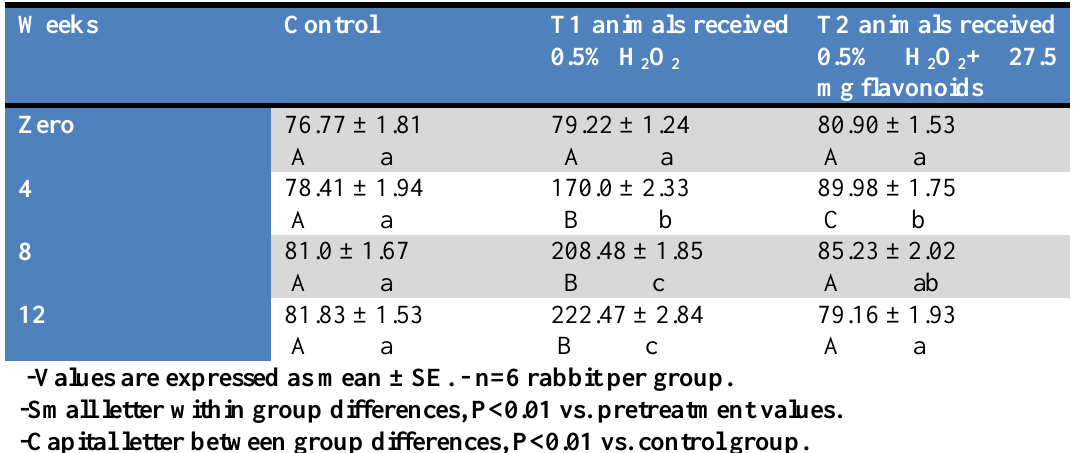
Table (8): Effect of flavonoids extracted from black cumin seeds for twelve weeks on serum low density lipoprotein (LDL-C) concentration (mg/dl) in control and H treated adult male rabbit.